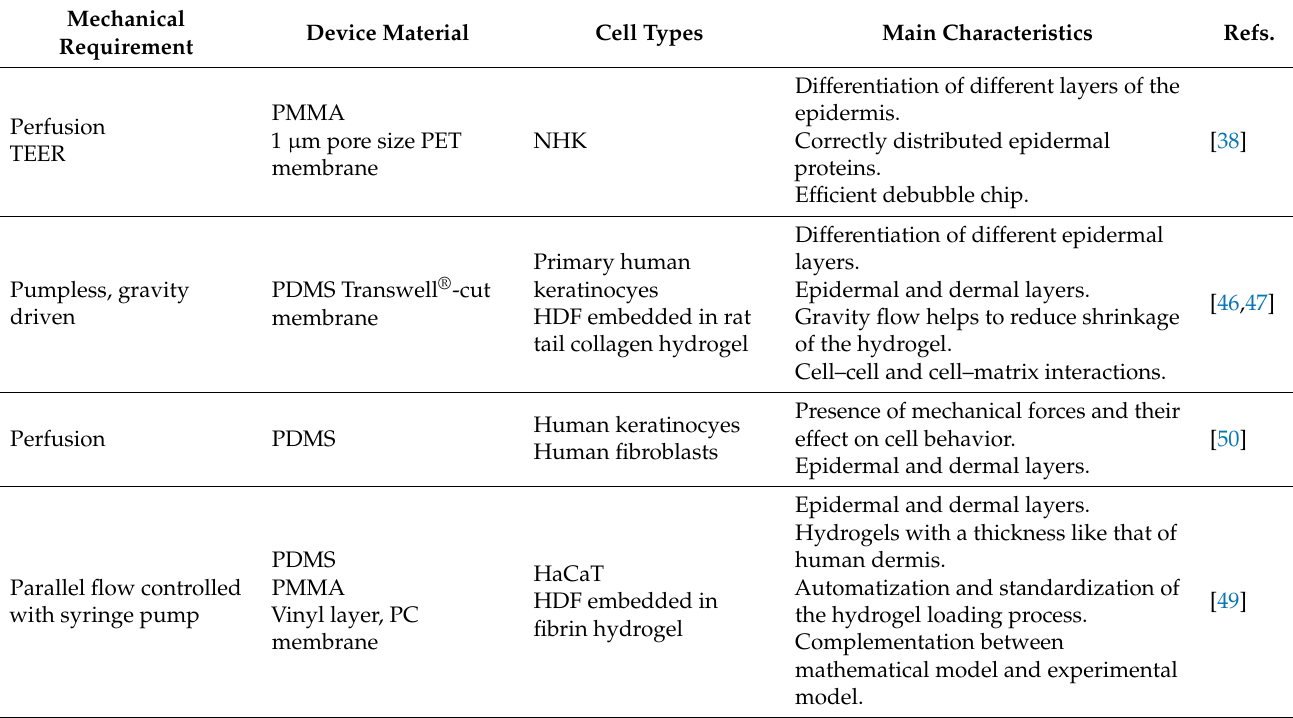
Table 3. Human SoCs reported with different mechanical